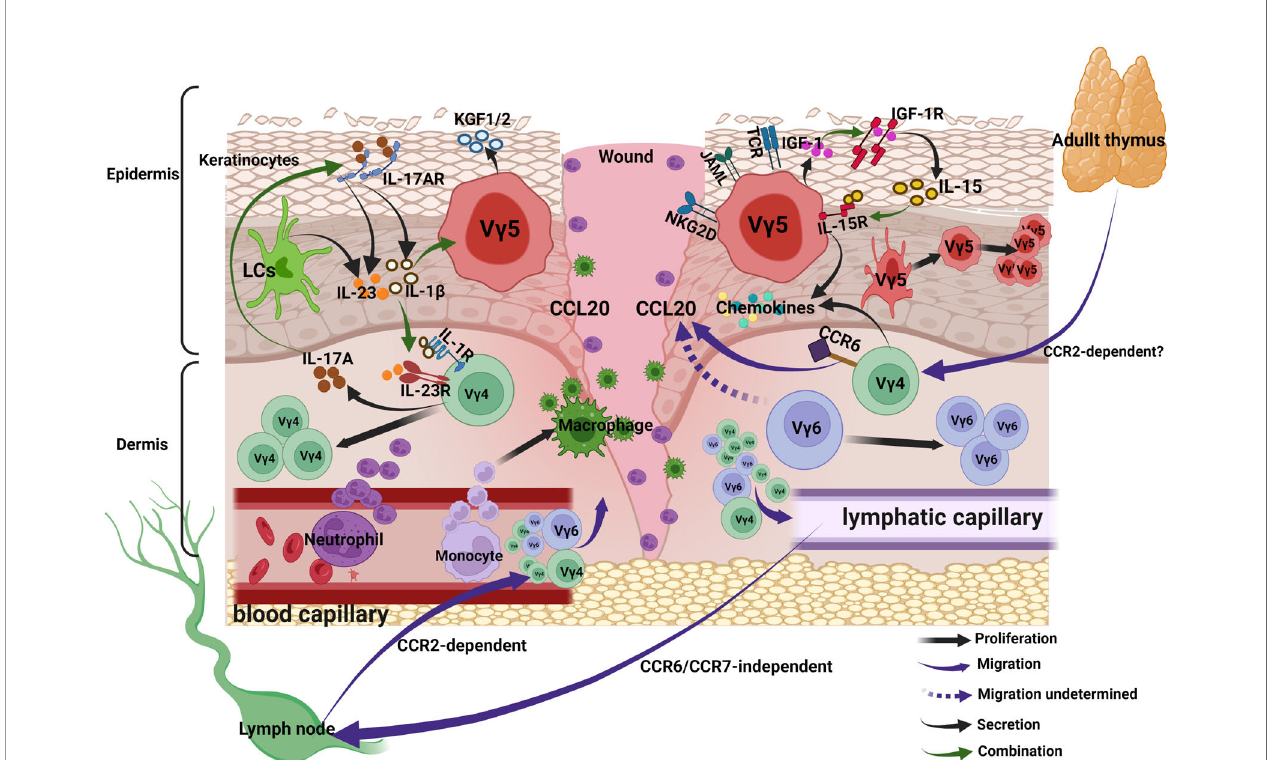
FIGURE 3 | gd T cells in acute wound healing. Upon activation, DETCs and V g 4 T cells secrete chemokines to recruit neutrophils and macrophages into lesion site. Activated V g 4 T cells migrate to epidermis via CCR6-CCL20 pathway, in addition, the traf fi c of V g 4 and V g 6 T subsets between skin and lymph nodes increases, the traf fi c from skin to lymph nodes is CCR6/CCR7-independent, while that from lymph nodes to skin is CCR2-dependent. Keratinocytes-derived IL-15 and DETCs- derived IGF-1 forms a positive feedback loop and promotes re-epithelialization. The positive feedback loop between wound-derived IL-1 b /IL-23 and V g 4-derived